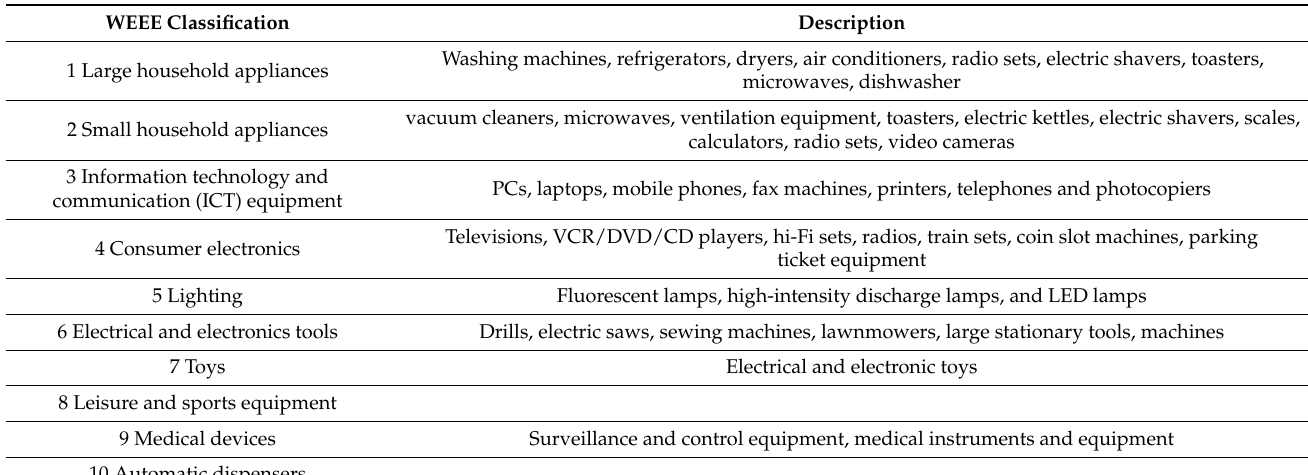
Table 1. Waste Electrical and Electronics Equipment categories